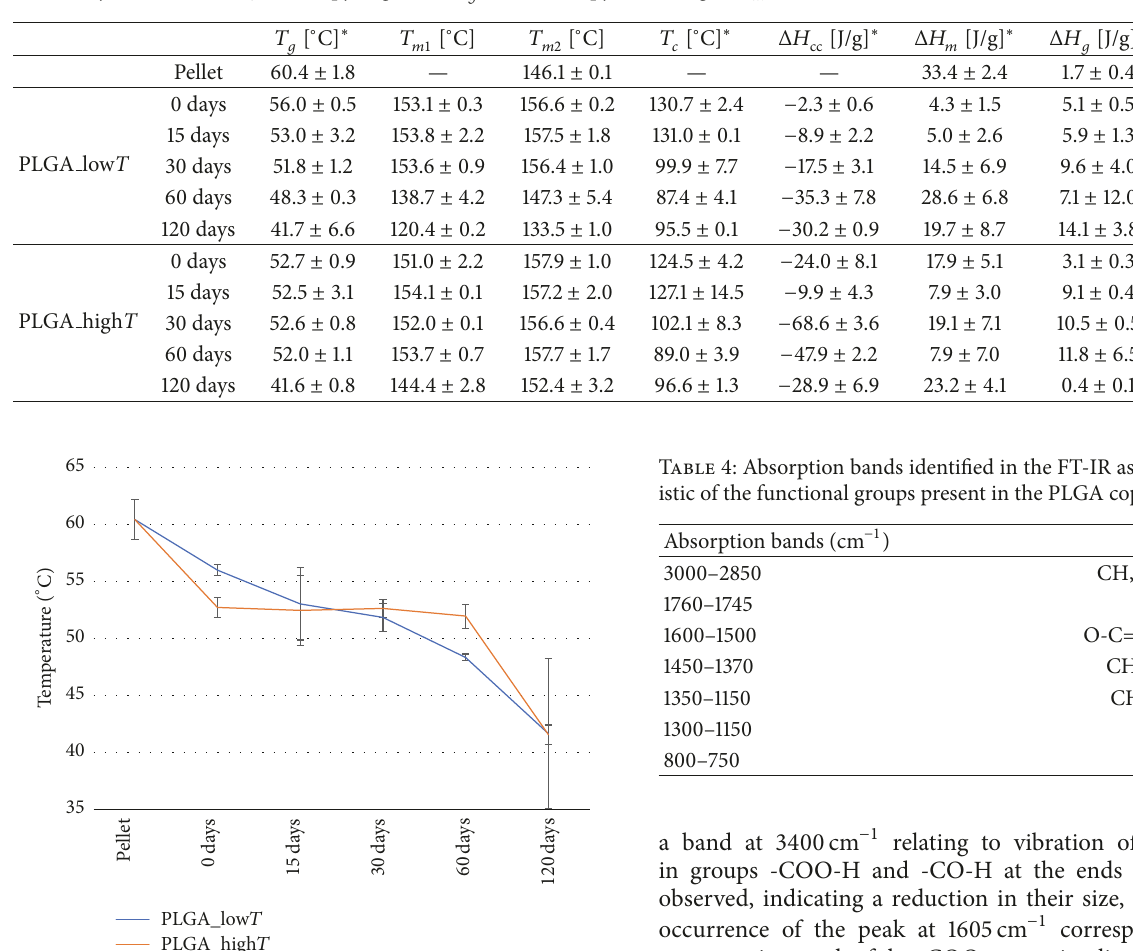
Table3:Degreeofcrystallinity( 𝑋 𝑐 )andthermalpropertiesmeasuredbyDSC:glass-transitiontemperature( 𝑇 𝑔 ),meltingpoint( 𝑇 𝑚 ),enthalpy of cold crystallization ( Δ𝐻 𝑐 ), enthalpy of glass ( Δ𝐻 𝑔 ), and enthalpy of melting ( Δ𝐻 𝑚 ) ( ∗ 𝑝 < 0.05 ).